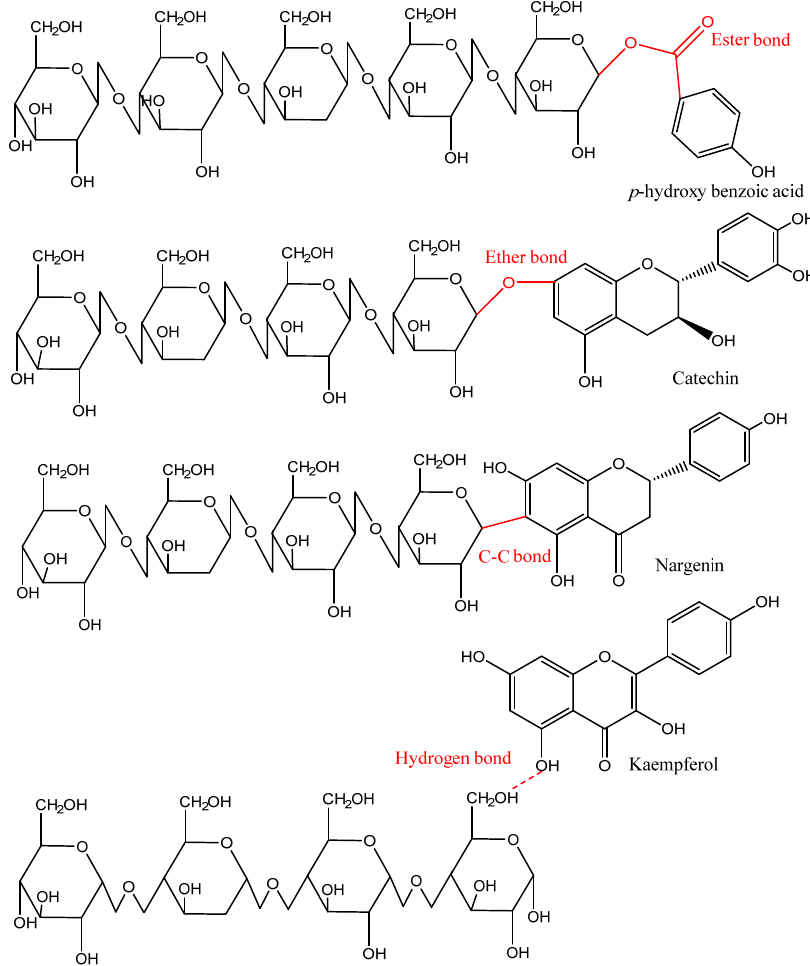
Figure 4. Representative covalent and hydrogen bonds found in the insoluble-bound phenolics and food matrix [2].